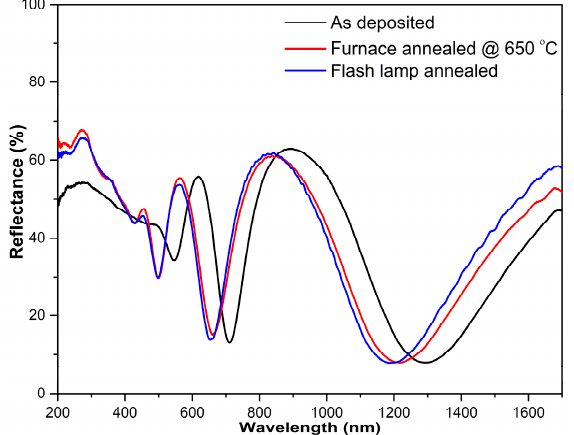
Figure 3. Reflectance spectra of as-deposited, furnace annealed at 650 °C and flash lamp annealed Si thin films.